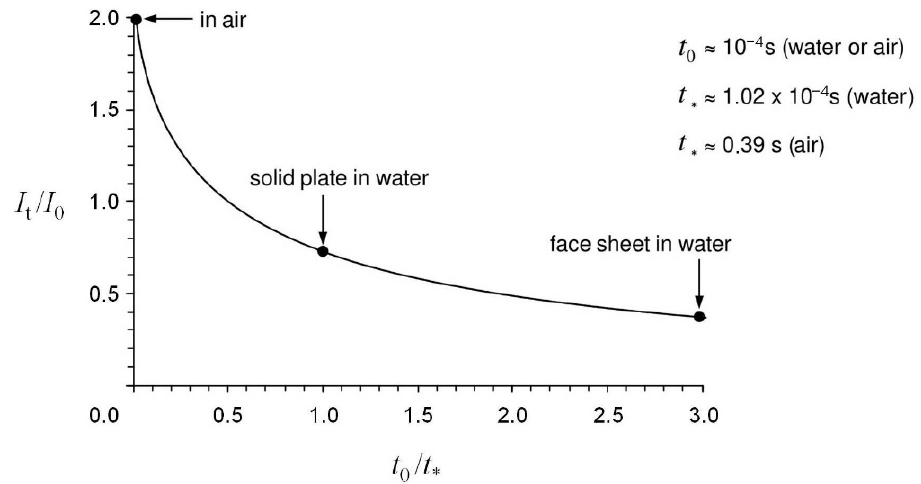
Figure 12. Plot of the momentum ratio I t / I 0 as a function of the time scale ratio q for assessing fluid–structure interaction according to the Taylor relationship.